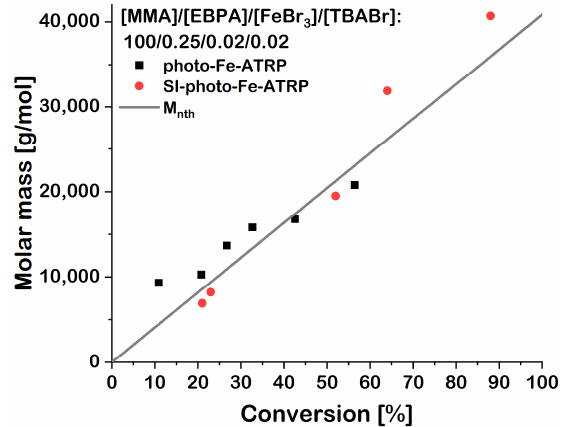
Figure 6. Plot presenting dependency of estimated M α of grafted PMMA brushes and M n of PMMA polymers obtained in solution during photo-Fe-ATRP vs. monomer conversion (conversions calculated by means of 1 H NMR).